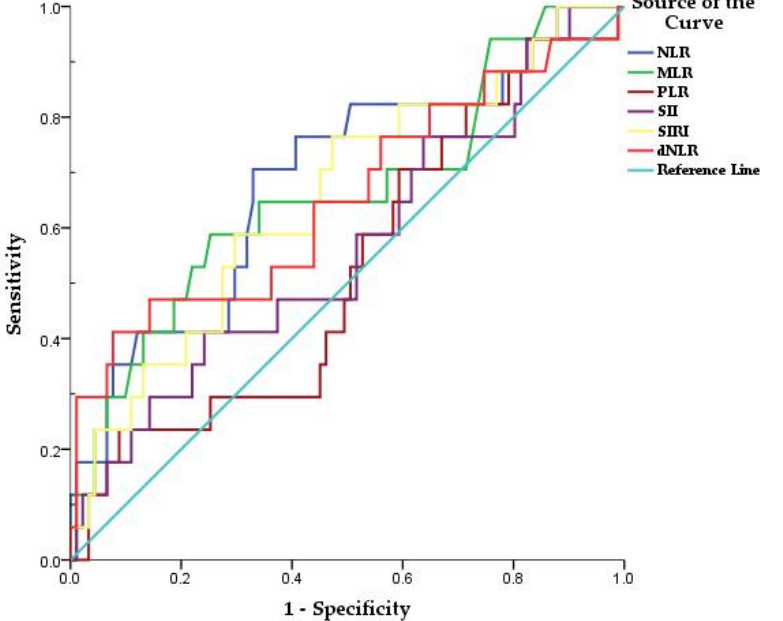
Figure 1. Receiver operating characteristic (ROC) curves of NLR, DNLR, MLR, PLR, SII, and SIRI in predicting death, in patients with COVID-19. Table 2. Receiver operating characteristics (ROC) curves, prognostic accuracy of inflammatory markers, and optimal cutoff.